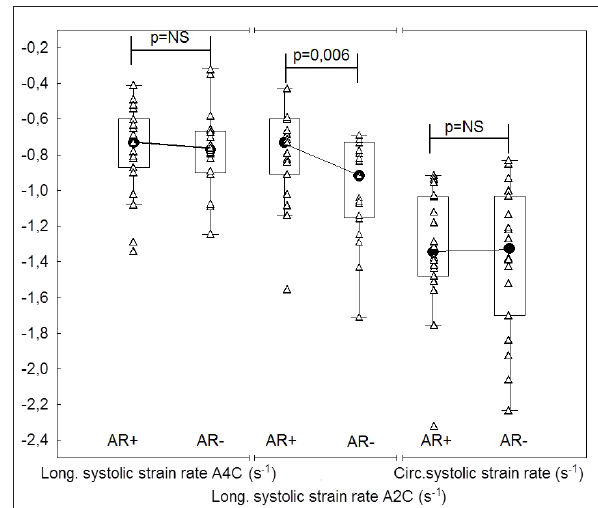
Fig. 1. Boxplots of individual strains of patients in the Rejection Group, where the triangles stand for the raw data, the connect- ing line points to the median, box stands for quartiles and the whiskers for non –outlier range. Graphs show the differences in individual strains in the time of rejection (AR+) to the time when patients were rejection free (AR–). Even though these are paired data, and P -values show the result of paired data analysis, boxplots were used to provide a better overview.